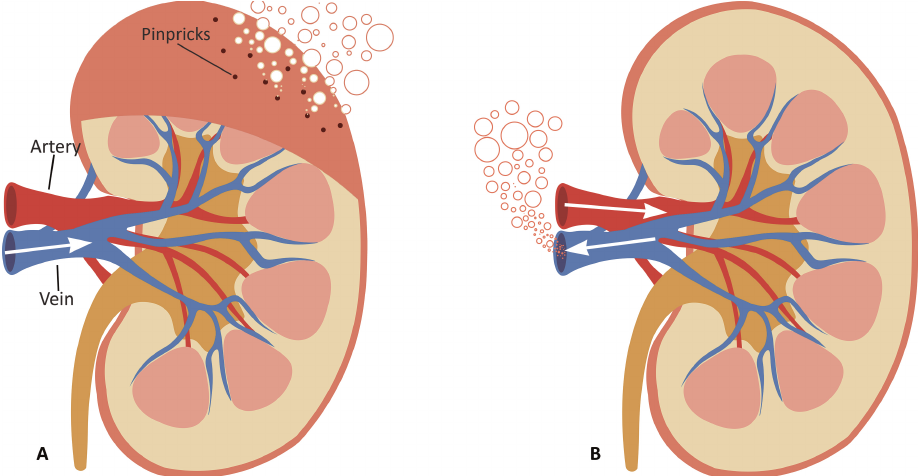
Figure 1. Cross-sectional diagram of the kidney being persufflated using two different approaches: ( A ) Retrograde Persufflation (R-PSF); with the gas being perfused through the vein and bubbling out through the pinpricks. ( B ) Anterograde Persufflation (A-PSF); with the gas being perfused through the artery and exiting through the